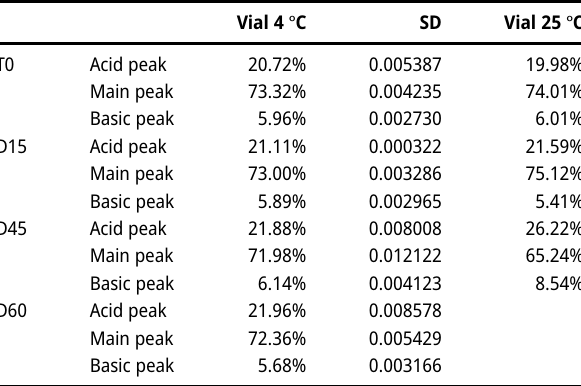
Table  : Relative % of isoforms of Bevacizumab demonstrated by ion exchange chromatography for vials containing  mg/mL and stored at  ° C (n=  ) and  ° C (n= 